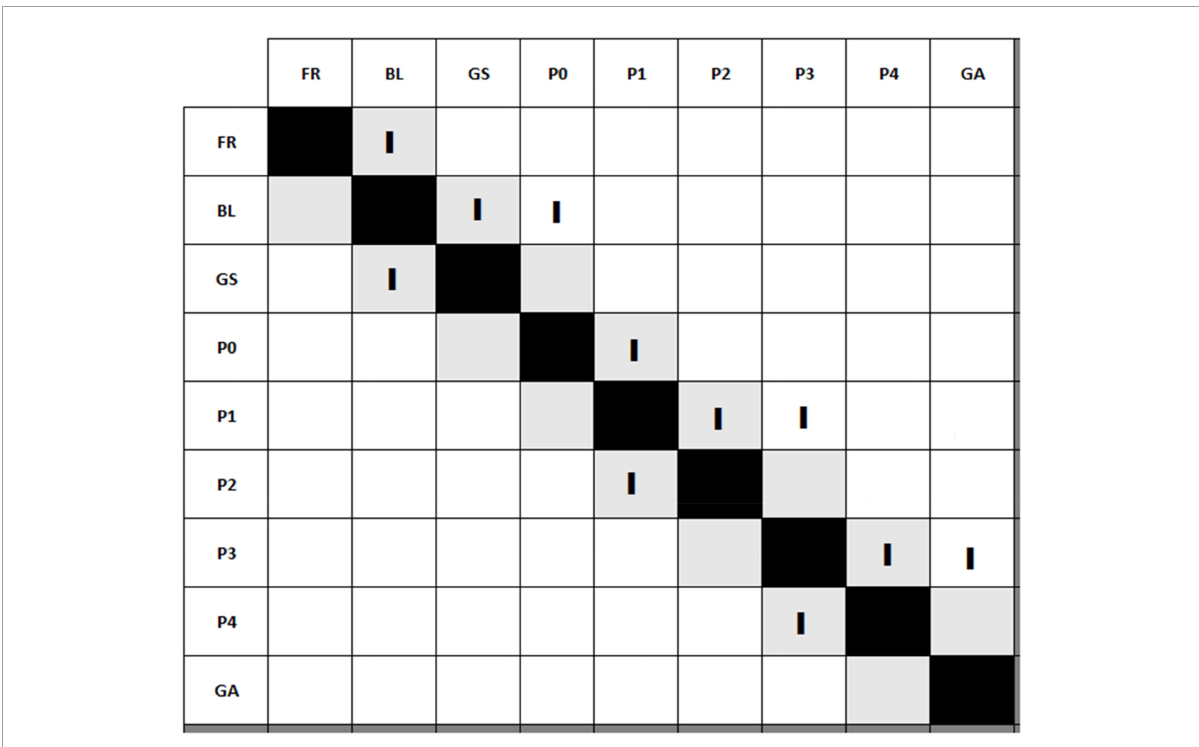
FIGURE3 Coding sheet for calculating the logical sequence percentages from the fixation sequence data. FR, Framing; BL, Baseline; GS, Goal setting; P0, Instructional phase 0; P1, Instructional phase 1; P2, Instructional phase 2; P3, Instructional phase 3; P4, Instructional phase 4; GA, Goal achievement. Figure adapted from Espin et al.